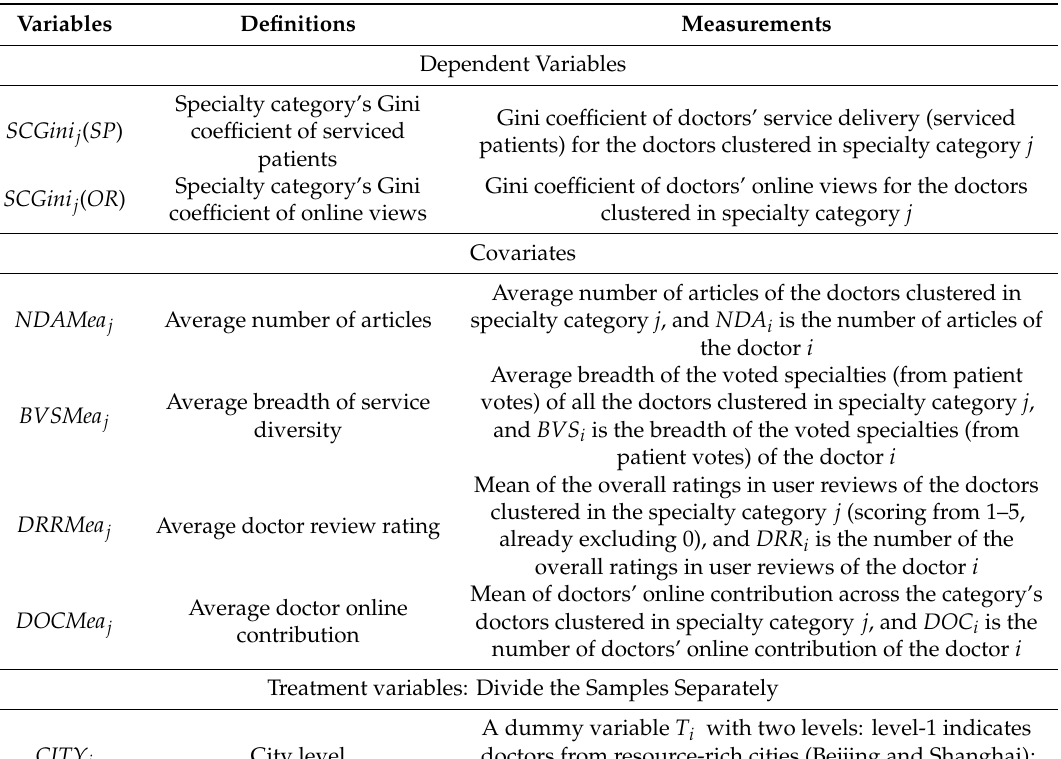
Table 1. Variable Definitions and